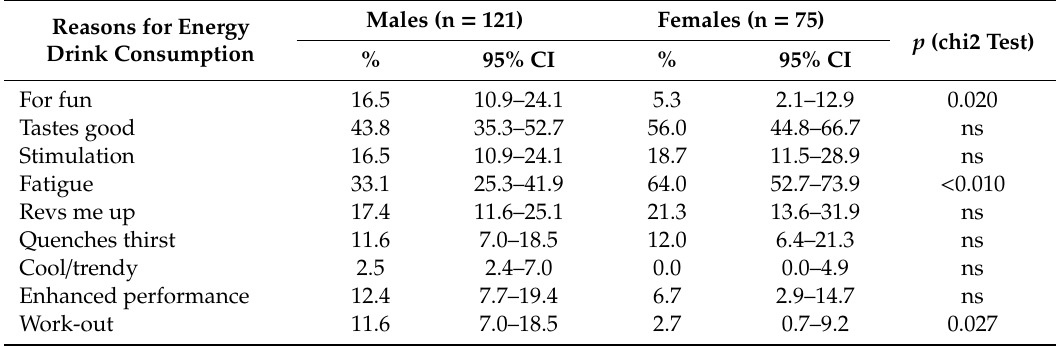
Table 2. Motivations for energy drink consumption according to